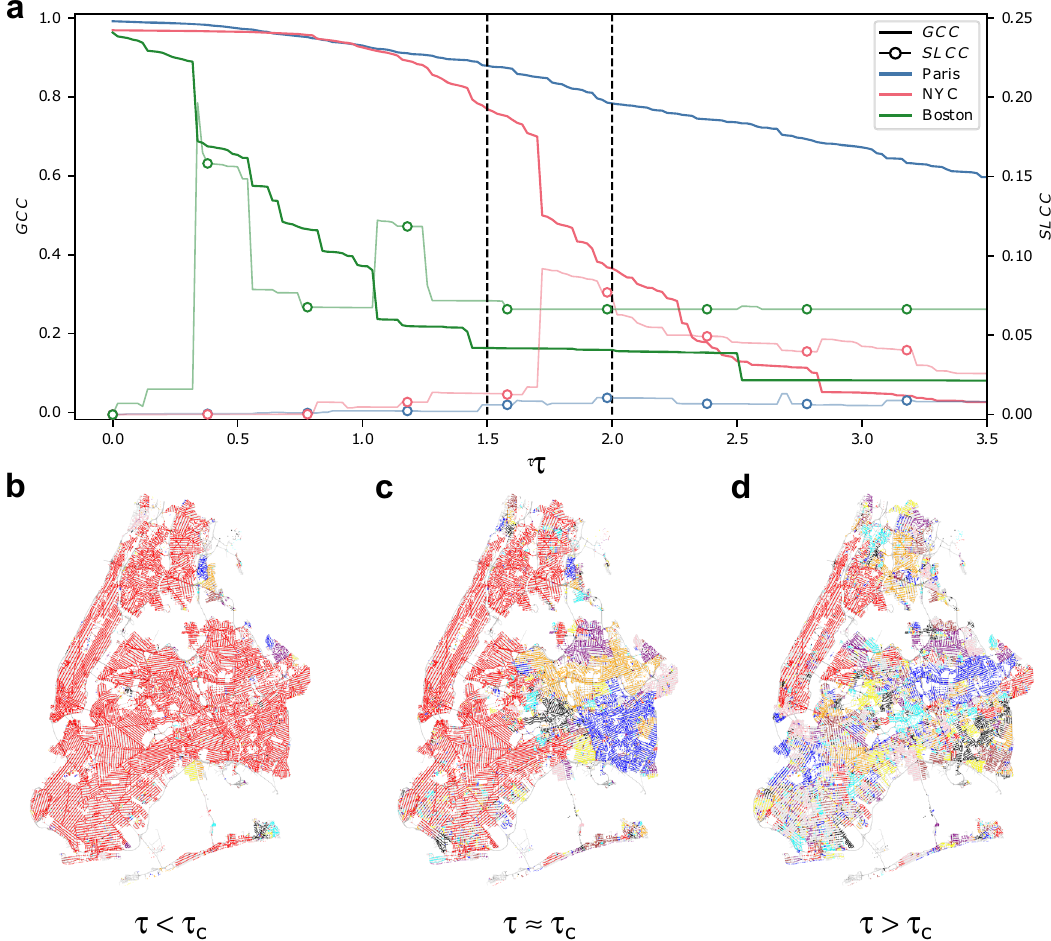
Fig. 3 Effective width ( w eff ) percolation in Boston, New York, and Paris. a Change in the size of the giant component GCC of the sidewalk network of Boston (green), New York City (red) and Paris (blue), as edges are iteratively removed at the threshold τ , from lower to higher w eff . The evolution of the second largest connected component SLCC is represented as well (right y-axis). The three cities react differently to sidewalk segment removal, with a collapsed sidewalk network in Boston and New York beyond τ = 2 m. As a visual aid, two dashed vertical lines at 1.5 and 2 m refer to the minimal width range necessary for an individual to maintain social distancing recommendations. b – d Sidewalk edges are colored according to the connected component they belong to. These panels correspond to three snapshots of New York ’ s breakdown around its critical percolation point τ c ≈ 1.6 m: from a pre-critical state ( τ < τ c ), to a dysfunctional stage at τ ≫ τ c , where several small clusters coexist (note that sidewalk nodes are colored according to the connected component to which they